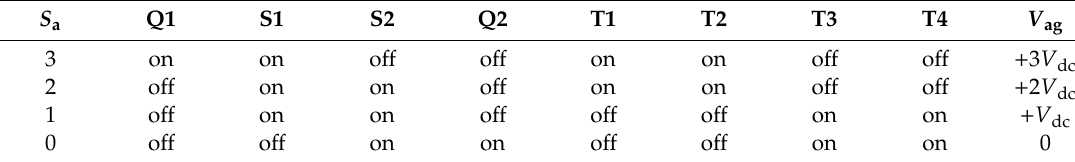
Table 3. Voltage transition and modified switching state in leg